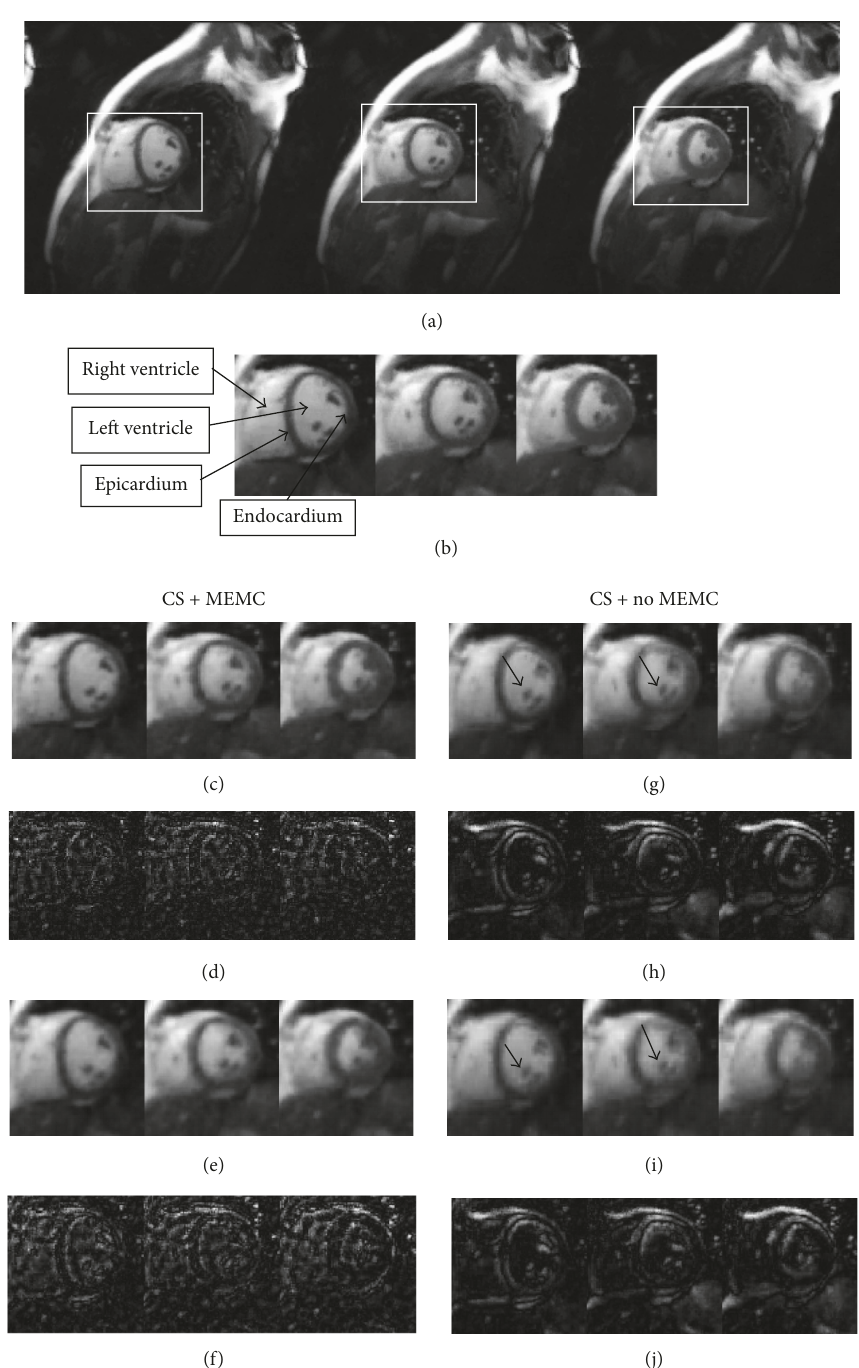
Figure 4: Comparison of recovered images with and without respiratory motion estimation for clinical data: frames diastolic, middle of diastolic and systolic, and systolic (left to right). (a) Gold standard images from full k -space data. (b) ROI. (c) Reconstruction using the proposed technique (CS + MEMC) at 𝑅 = 3 . (d) Difference between estimated images (c) and (b). (e) Reconstruction using the proposed technique (CS + MEMC) at 𝑅 = 8 . (f) Difference between estimated images (e) and (b). (g) Reconstruction with CS + no MEMC at 𝑅 = 3 . (h) Difference between estimated images (g) and (b). (i) Reconstruction CS + no MEMC at 𝑅 = 8 . (j) Difference between estimated images (i) and